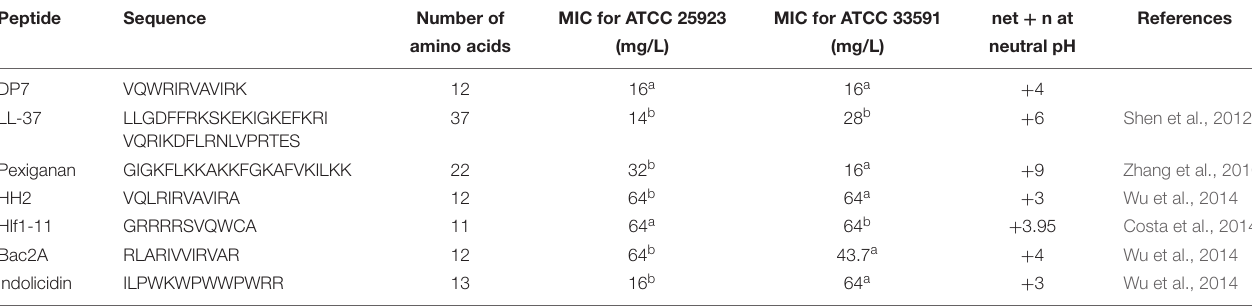
TABLE 1 | MIC of various AMPs against S. aureus.